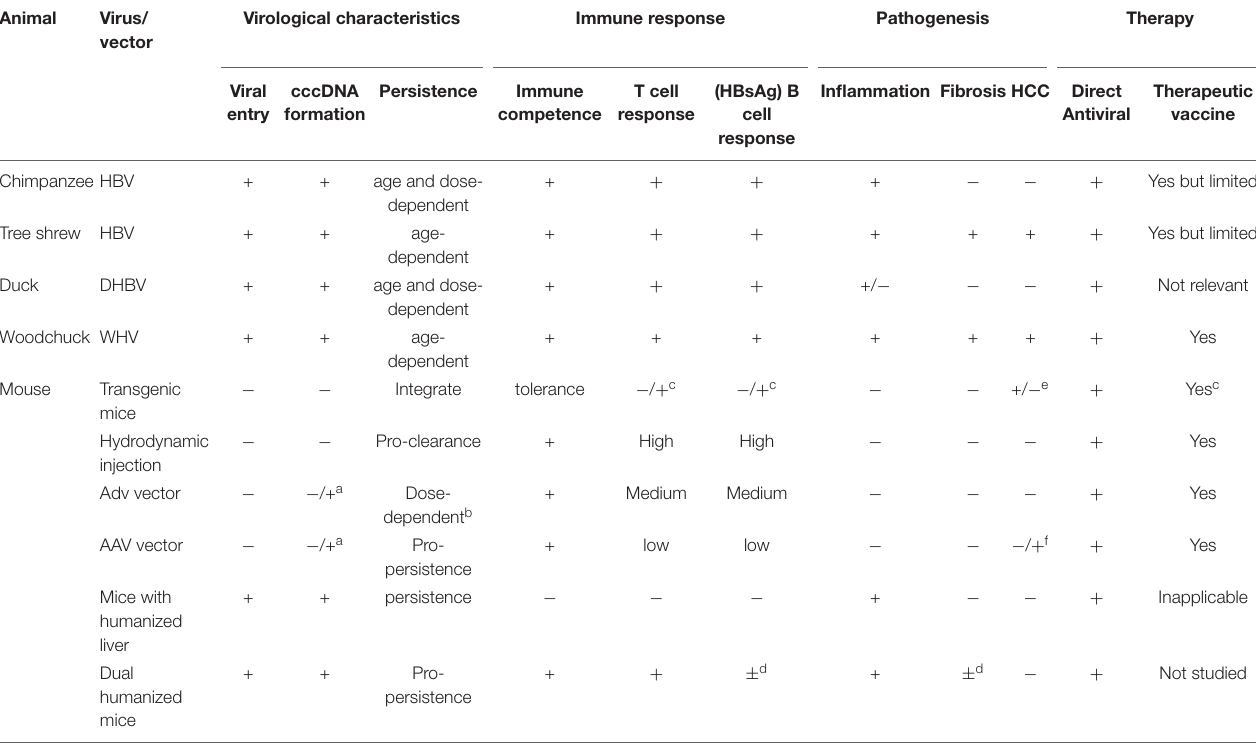
TABLE 1 | Basic features of animal models for major